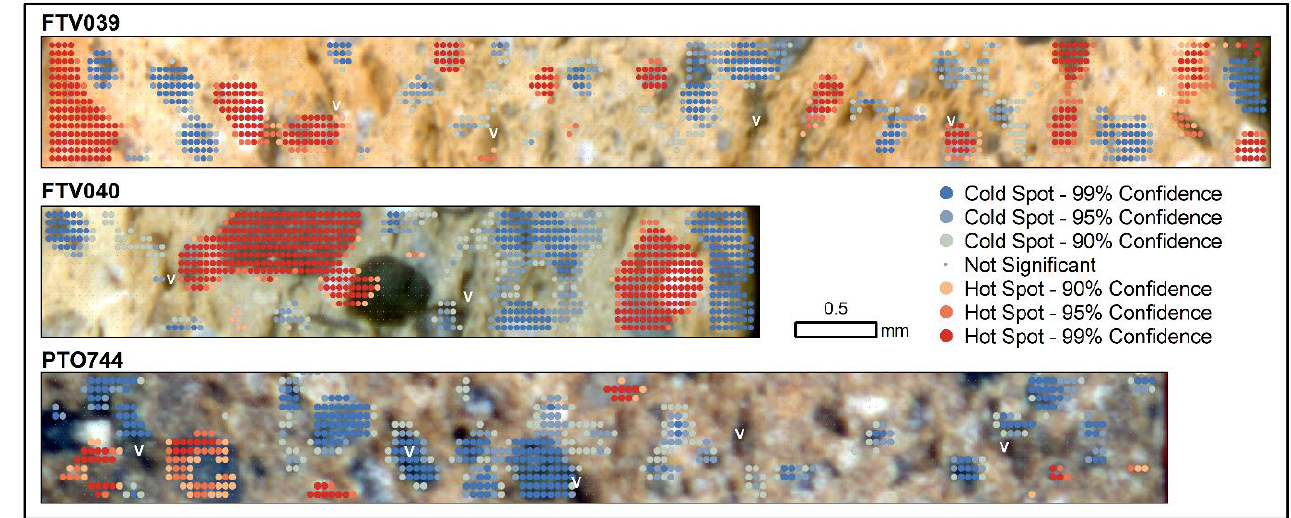
Figure 7. Results of Getis-Ord Gi* showing hot and cool spots across Group A1 ceramics. “V” marks macroscopically visible voids.